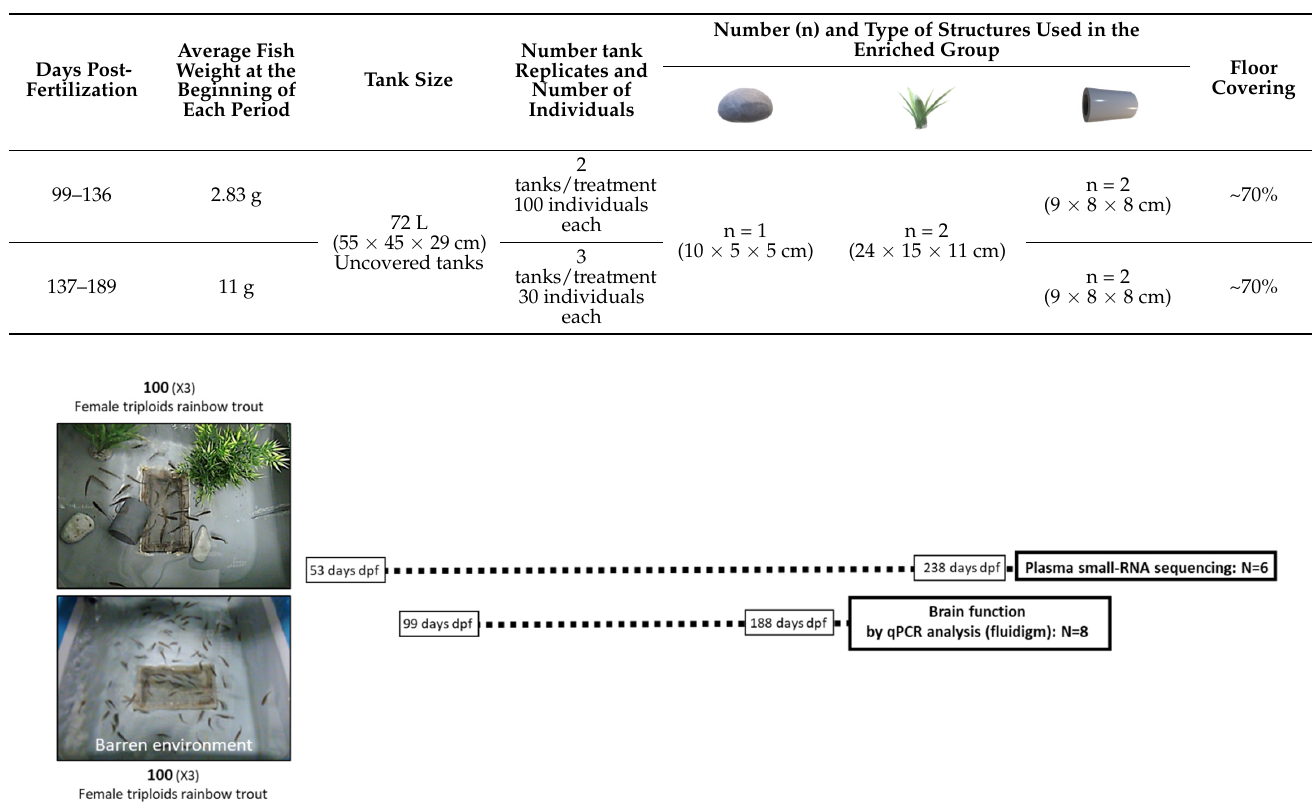
Table 2. In batch 2: mean fish weight, tank size, number of individuals, number, type and size of structures, and estimated floor covering at each stage.